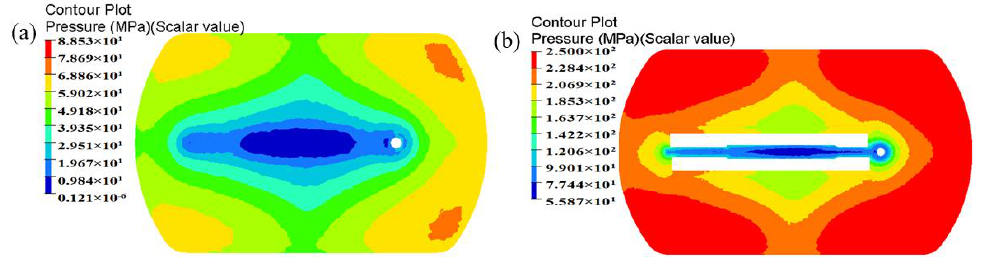
Figure 17. Comparison of the welding pressure distribution in middle height of the welding chamber ( a ) the initial die and ( b ) the optimal die.